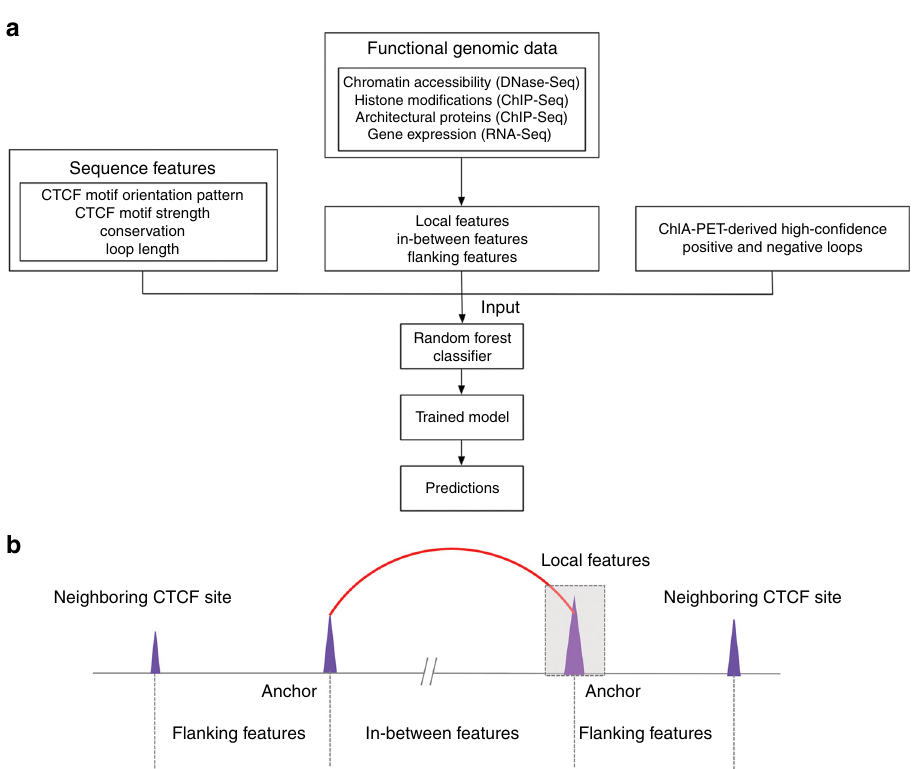
Fig. 2 Illustration of the Lollipop pipeline. a Schematic of the Lollipop pipeline. In training data, positive loops were generated from high-con fi dence interactions identi fi ed from ChIA-PET, and negative loops were random pairs of CTCF-binding sites without interactions in ChIA-PET or signi fi cant contact in Hi-C data set. A diverse set of features, generated from genomic and epigenomic data, was used to characterize the interactions. A random forests classi fi er distinguished interacting CTCF-binding sites from non-interacting ones. The performance of resulting classi fi er was then evaluated. Trained model can be used to scan the genome and predict de novo CTCF-mediated loops in the same or a different cell type. b Illustration of local, in-between, and fl